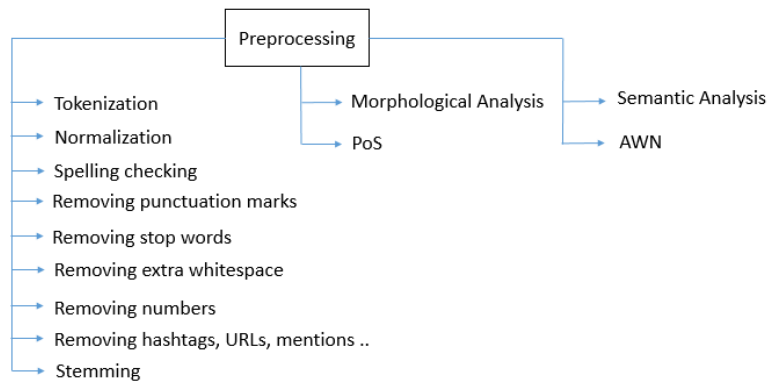
Figure 3: Preprocessing.